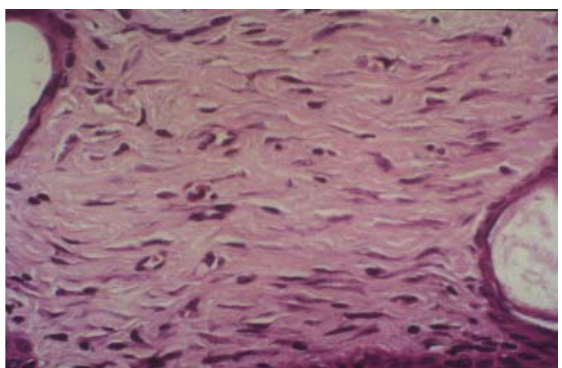
FIGURE 3 - Photomicrograph of the rat skin day 21 post peeling using TCA, in the experimental group (G2) (HE, 100x). There is an increased number of fibroblasts,with compact eosinophitic colagen fibers.